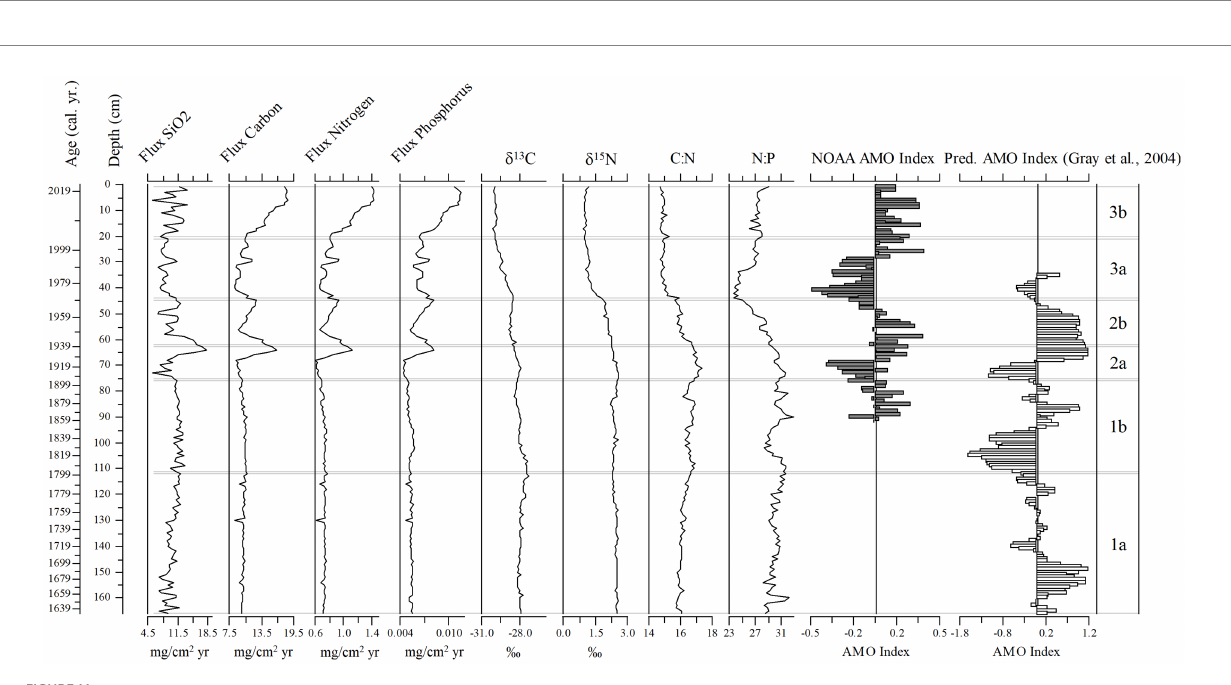
FIGURE 11 Stratigraphic diagram of flux rates of silica (SiO2), nitrogen, carbon, and phosphorus, ẟ 15 N and ẟ 13 C values, and the C:N and N:P ratios, from the sediment core (166 cm, 1633–2019). The timeseries for the AMO Index and the predicted AMO Index (Gray et al., 2004 model) are also